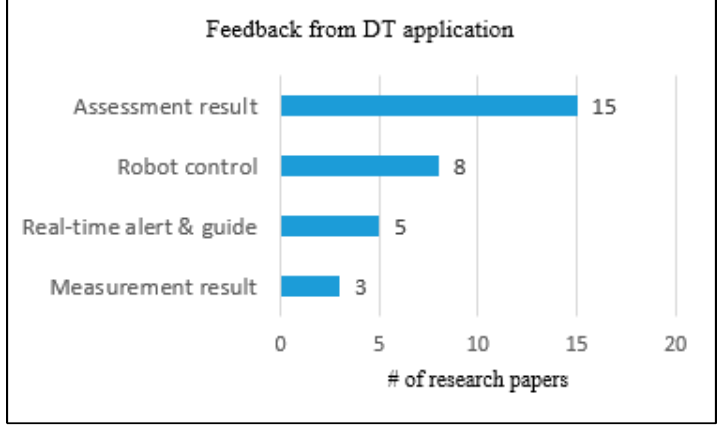
Figure 11. Feedback provided by the existing